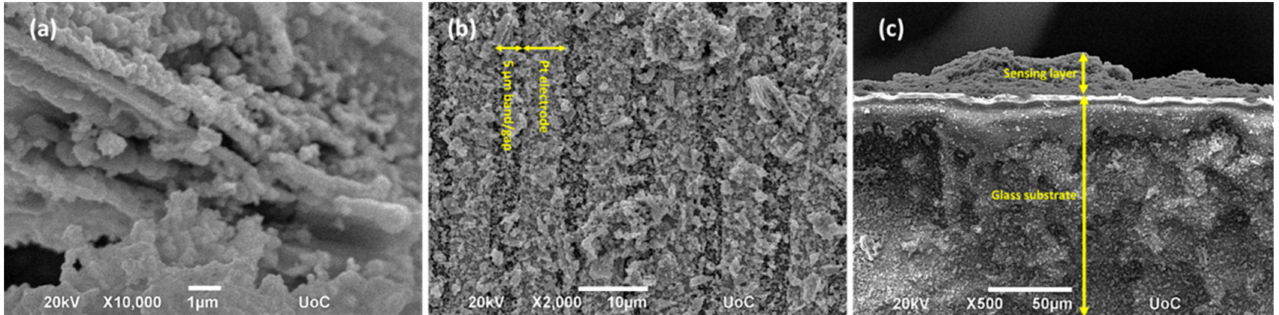
Figure 4. ( a ) SEM images of Co 3 O 4 nanoparticles; ( b , c ) micrographs of Co 3 O 4 sensing elements, after thermal annealing and before sensing